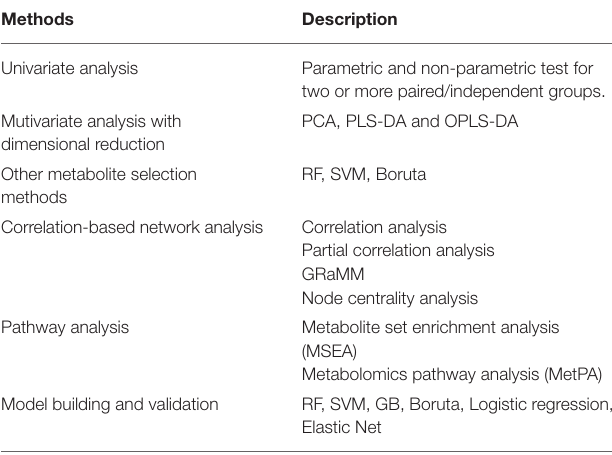
TABLE 1 | Metabolites-selection methods provided by iMAP modules.